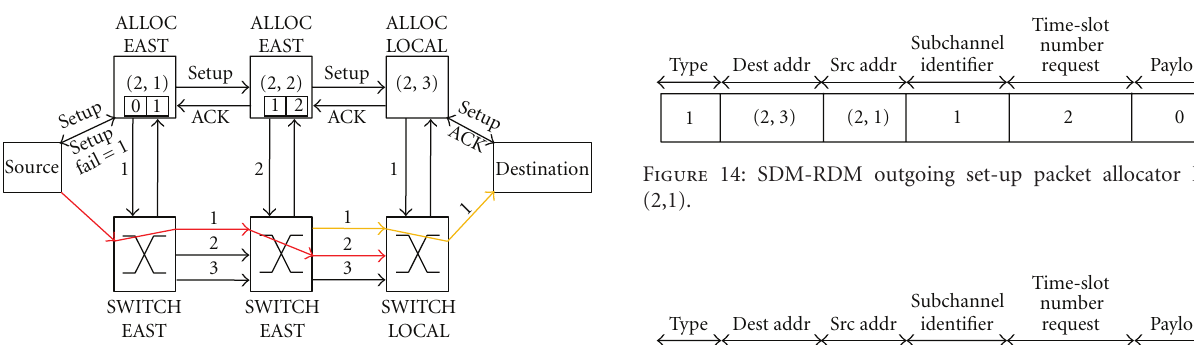
Figure 12: Failed path establishment in SDM-based router.